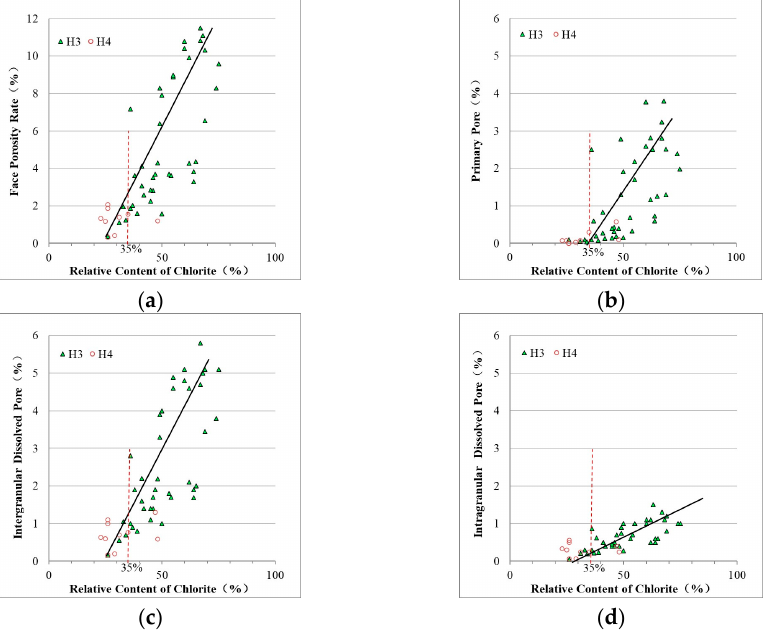
Figure 12. Diagram of correlation between chlorite content and pore development. ( a ) Correlation between relative content of chlorite and face porosity rate; ( b ) Correlation between relative content of chlorite and primary pore; ( c ) Correlation between relative content of chlorite and intergranular dissolved pore; ( d ) Correlation between relative content of chlorite and intragranular dissolved pore.